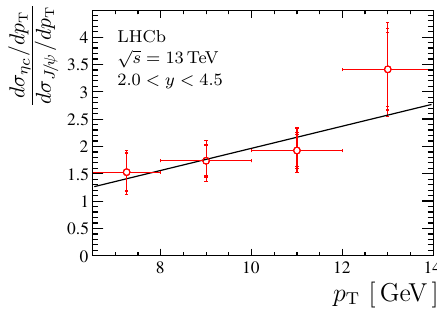
→ pp and J /ψ → pp branching fractions, respectively. For the η c relative prompt production cross-section, the result of a fit with a linear function is overlaid